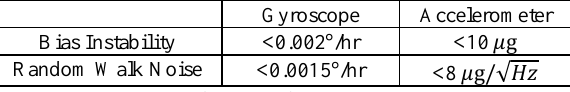
Table 4. The specification of iMAR iNAV-RQH-10018